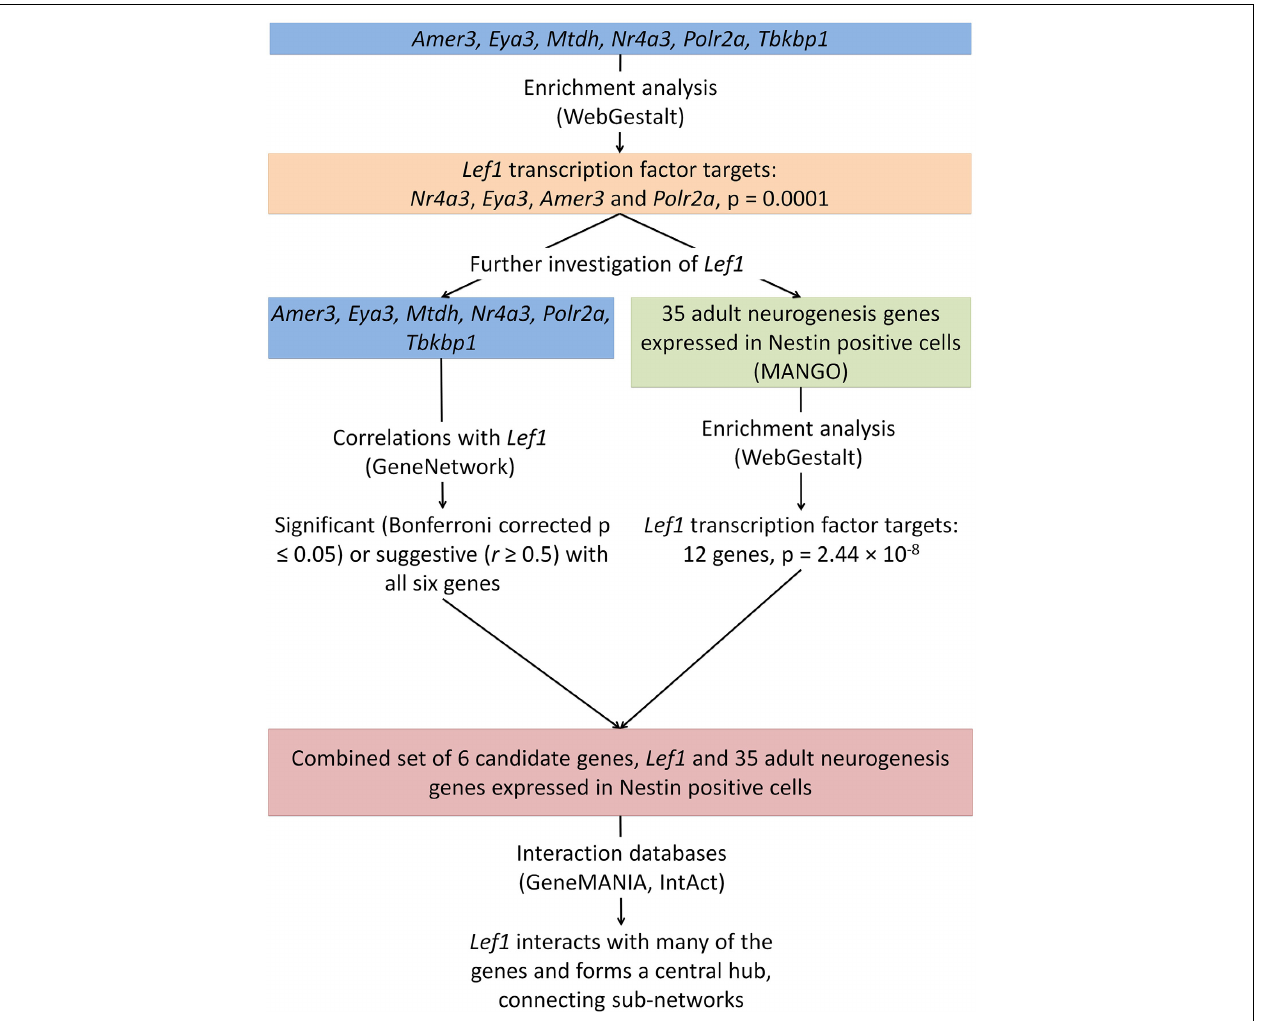
FIGURE 3 | The integration of data from several online tools identifies a novel role for Lef1 in adult hippocampal neurogenesis. Enrichment analysis was carried out on the six candidate genes identified ( Figure 1 ) and for targets of the transcription factor Lef1. This